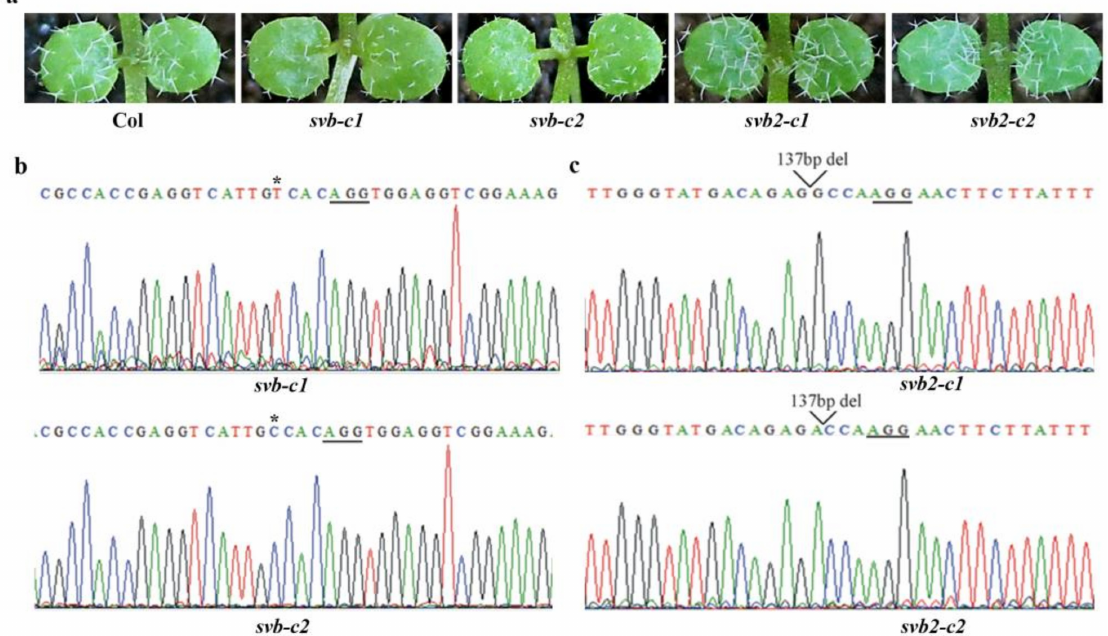
Figure 3. Mutations of SVB but not SVB2 affect trichome development. ( a ) Trichome phenotypes of the Col wild type, the svb and svb2 single mutants. Seeds of the Col wild type, the svb-c1 , svb-c2 , svb2-c1 and svb2-c2 mutants were sow directly into soil pots and grown in a growth room, and trichome phenotypes on the first two rosette leaves of 10-day-old seedlings were examine under a Motic K microscope and pictures were taken by using an EOS 1100D digital camera connected to the microscope. ( b ) Editing status of SVB in the svb-c1 and svb-c2 mutants. DNA was isolated from normal flowering T2 plants, and sequenced. Underlines indicate the PAM sites, and stars indicate the single nucleotide inserted in the target sequences. ( c ) Editing status of SVB2 in the svb2-c1 and svb2-c2 mutants. DNA was isolated from normal flowering T2 plants, and sequenced. Underlines indicate the PAM sites, and open arrow heads indicate the sites where small fragments were